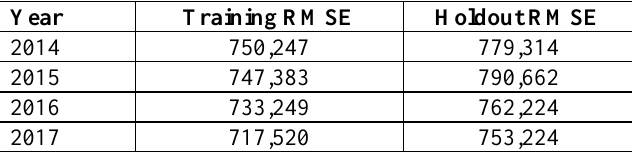
Table 7: GBM Default Hyperparameter Summary